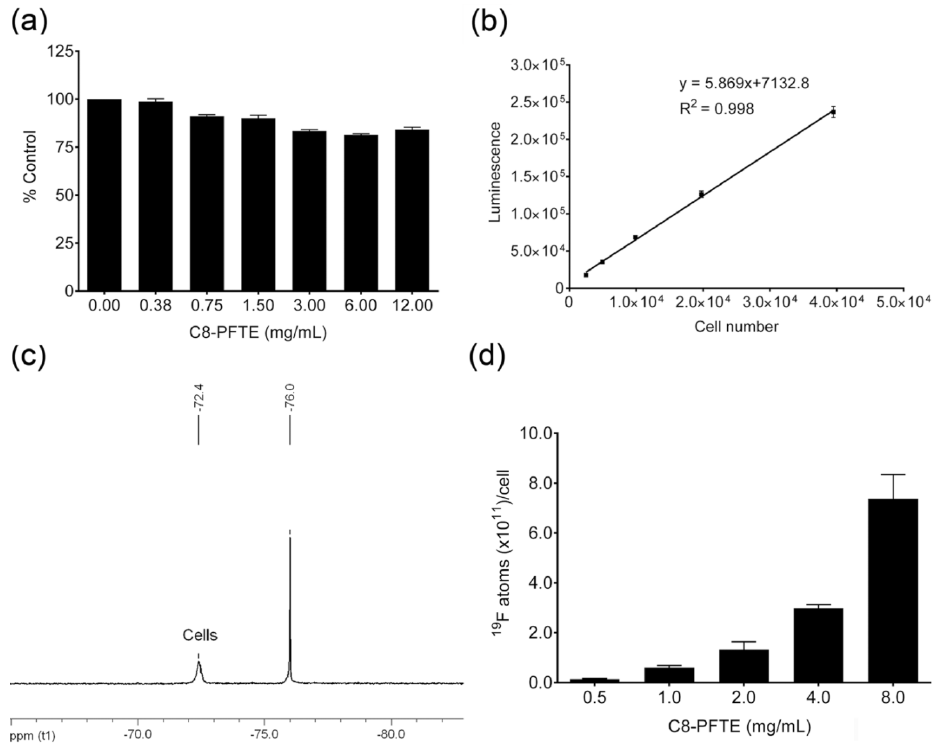
Figure 6. In vitro characterization of M2 nanoemulsion in mouse macrophages. ( a ) Macrophage viability post 24 h exposure to M2 nanoemulsion. Graph shows mean and